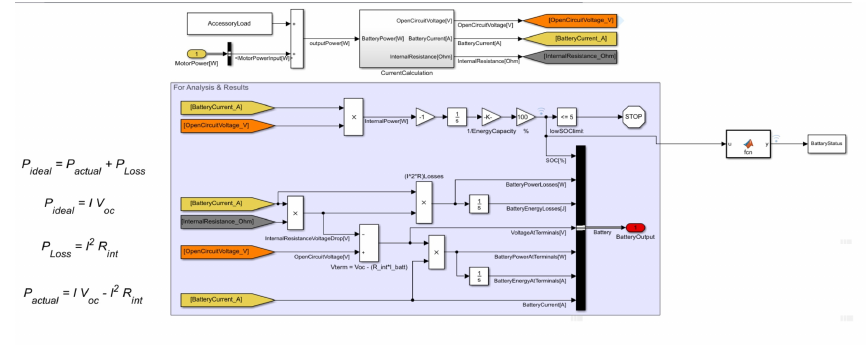
Figure 17. Battery simulation in the proposed